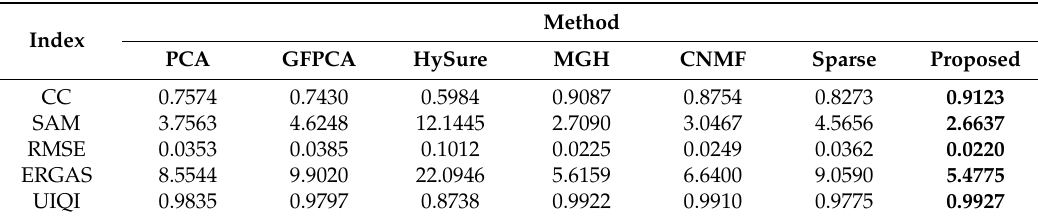
Figure 11. Visual comparison of different hyperspectral pan-sharpening methods for Hyperion dataset. ( a ) Interpolated HS image; ( b ) P image; ( c ) PCA; ( d ) GFPCA; ( e ) HySure; ( f ) MGH; ( g ) CNMF; ( h ) Sparse Representation; ( i ) Proposed. Table 4. Quality metrics of different methods for Hyperion dataset.